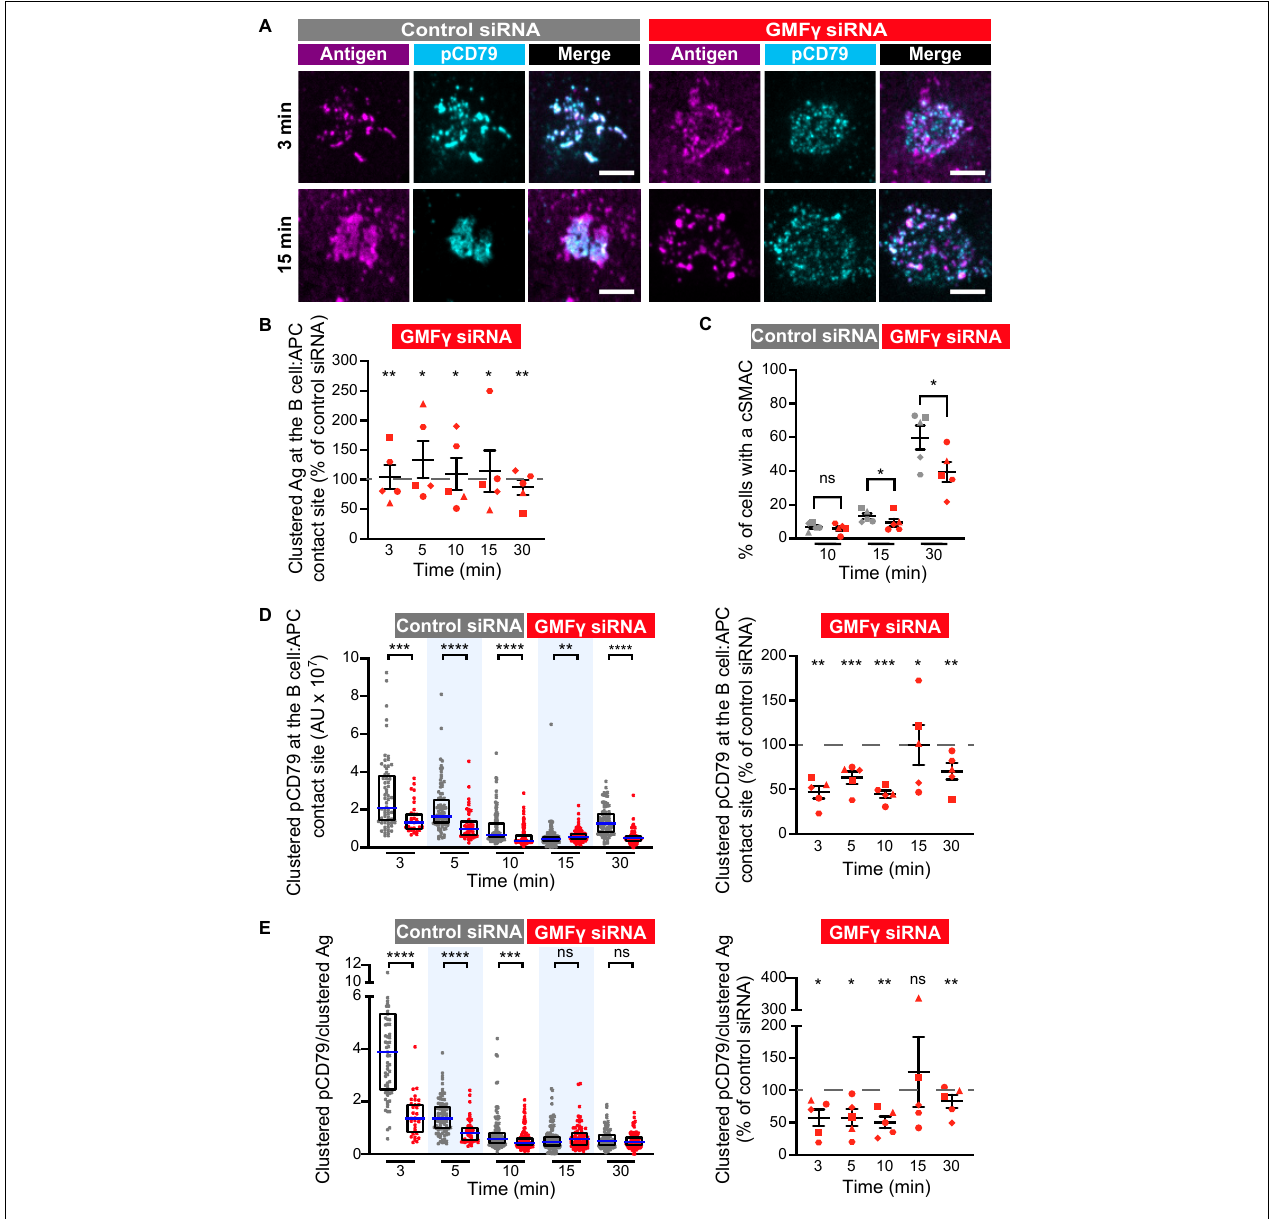
FIGURE 5 | Depleting GMF γ reduces cSMAC formation and proximal BCR signaling at the immune synapse. Raji D1.3 B cells were transfected with either control siRNA or GMF γ siRNA and added to COS-7 APCs expressing the mHEL-HaloTag Ag (magenta). The cells were fixed at the indicated times and stained with an antibody that recognizes the phosphorylated CD79 ITAMs (pCD79, cyan). The B cell-APC interface was imaged by spinning disk microscopy. (A) Representative images from one of five independent experiments. Scale bars: 5 µ m. (B) The total fluorescence intensity of the mHEL-HaloTag Ag that had been gathered into clusters at the B cell-APC contact site was quantified for each B cell and the median values were calculated for each time point. Each symbol on the graph represents the median value for the GMF γ knockdown cells, expressed as a percent of the median value for the control siRNA-transfected cells for the same time point in the same experiment. The differently shaped symbols represent five independent experiments. Paired t -tests were used to calculate p -values. (C) The percent of cells that had formed a cSMAC, defined as > 90% of the total Ag fluorescence intensity being contained in one or two clusters, is graphed. The different symbols represent independent experiments. Paired t -tests were used to calculate p -values. (D) The total fluorescence intensity of pCD79 that was present in clusters at the B cell-APC contact site was quantified for each B cell. The left panel shows representative data from one experiment. Each dot is one cell. n > 31 cells per condition. The median (blue line) and interquartile ranges (black box) are shown. The Mann-Whitney U -test was used to calculate p -values. The right panel shows the results from five independent experiments, presented as in (B) , with n > 30 cells per condition in each experiment. Each symbol represents a single experiment in which the median pCD79 fluorescence intensity for GMF γ -depleted cells is expressed as a percent of the corresponding median value for the control cells. Paired t -tests were used to calculate p -values. (E) For each B cell represented in (D) , the total fluorescence intensity of clustered pCD79 was divided by the total fluorescence intensity of the clustered mHEL-HaloTag Ag. The median (blue line) and interquartile ranges (black box) are shown. The data are presented as in (B , D) . **** p < 0.0001; *** p < 0.001; ** p < 0.01; * p < 0.05; ns, not significant ( p > 0.05).